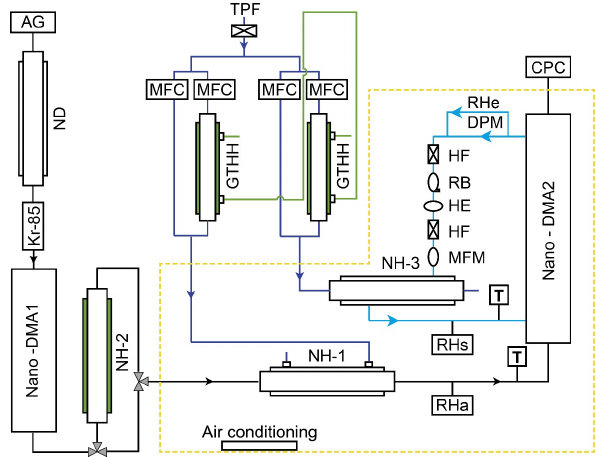
Figure 1. Experimental setup of the nano-HTDMA. Note: AG – aerosol generator (aerosol atomizer or electrospray); ND – Nafion dryer; Kr-85 – Krypton source aerosol neutralizer; nano-DMA – nano differential mobility analyzer; TPF – total particle filter; HF – hydrophobic filter; MFC – mass flow controller; MFM – mass flow meter; RB – recirculation blower; DPM – dew point mirror; GTHH – Gore-Tex humidifier and heater; NH – Nafion humidifier; HE – heat exchanger; CPC – condensation particle counter; black line – aerosol line; blue line – sheath line; royal blue line – humidified air; and green line – Milli-Q water (resistivity of 18.2M (cid:127) cm at 298.15K). RH a and RH s (measured by RH sensors) represent the relative humidity (RH) of aerosol and sheath flow in the inlet of nano-DMA2, respectively. RH e (measured by dew point) represents the RH of excess air. T represents the temperature of aerosol and sheath flow in the inlet of nano-DMA2,